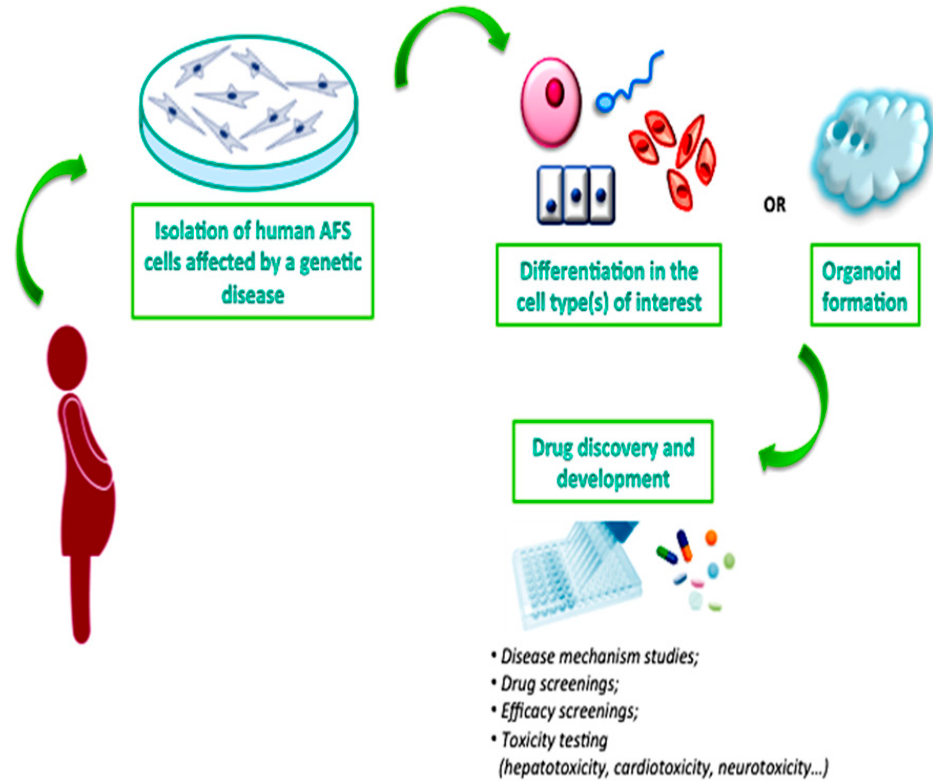
Figure 2. AFS cells as a novel system for drug development.